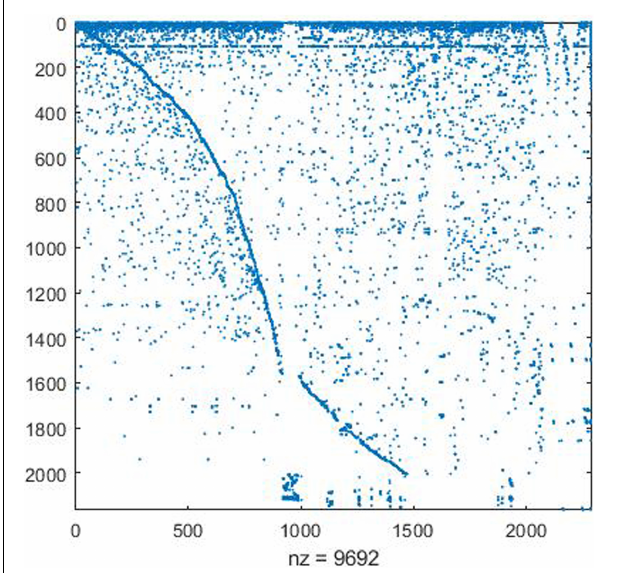
FIGURE 1 | Visualization of stoichiometric matrix.